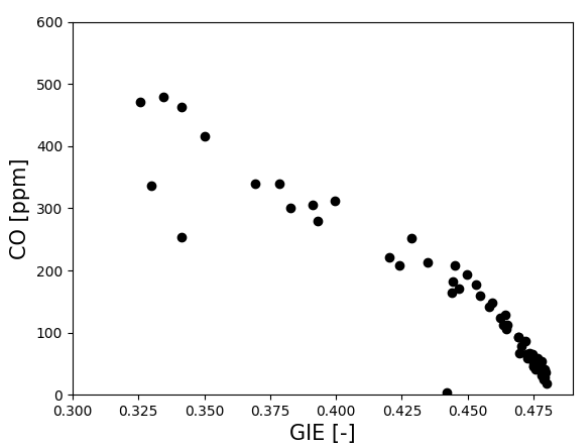
Figure 11. CO –efficiency